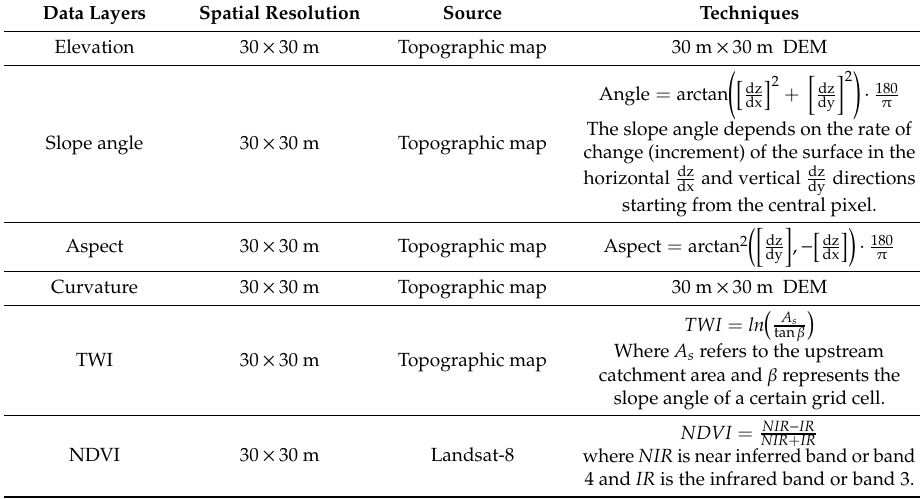
Figure 5. Landslide impact factors. ( a ) Elevation; ( b ) Slope; ( c ) Aspect; ( d ) Curvature; ( e ) TWI; ( f ) NDVI; ( g ) Land use; ( h ) Soil type; ( i ) Lithology; ( j ) Distance to fault; ( k ) Distance to stream; and ( l ) Distance to road. Table 1. The conditioning factors used in this study and their significance on landslide occurrence.